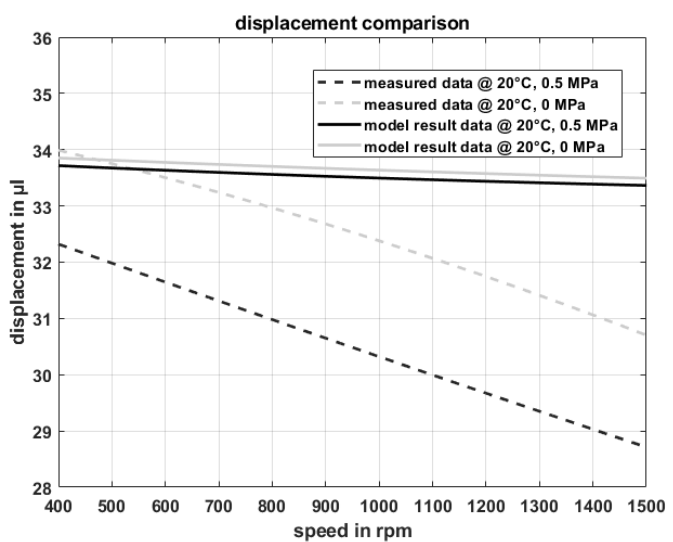
Figure 31. Displacement characteristics at 20 °C; idle and nom. load (5 bar) and varying frequency; measurement vs. simple algebraic model (the graph was corrected with a constant factor to reach the measured initial displacement at 0 rpm to equalize the causes due to manufacturing tolerances and assembling).